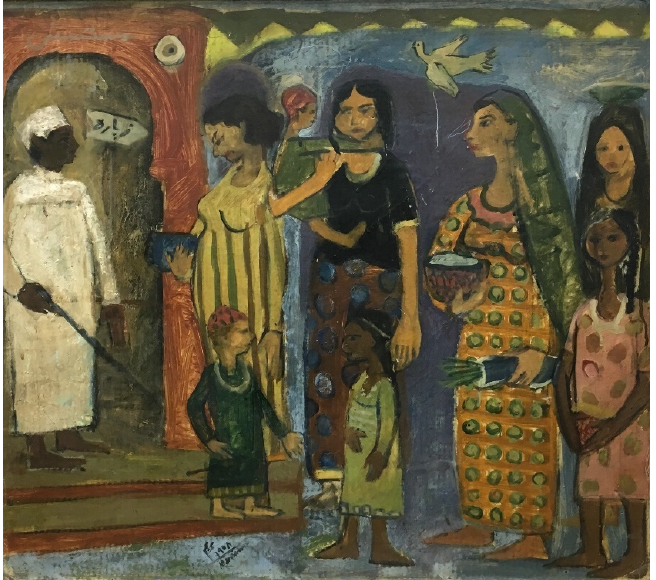
Figure 8. Maryam Abdel-Aleem, Clinic (1958). Oil on board, 77 × 83 cm. Image, courtesy of Barjeel Art Foundation, Sharjah .